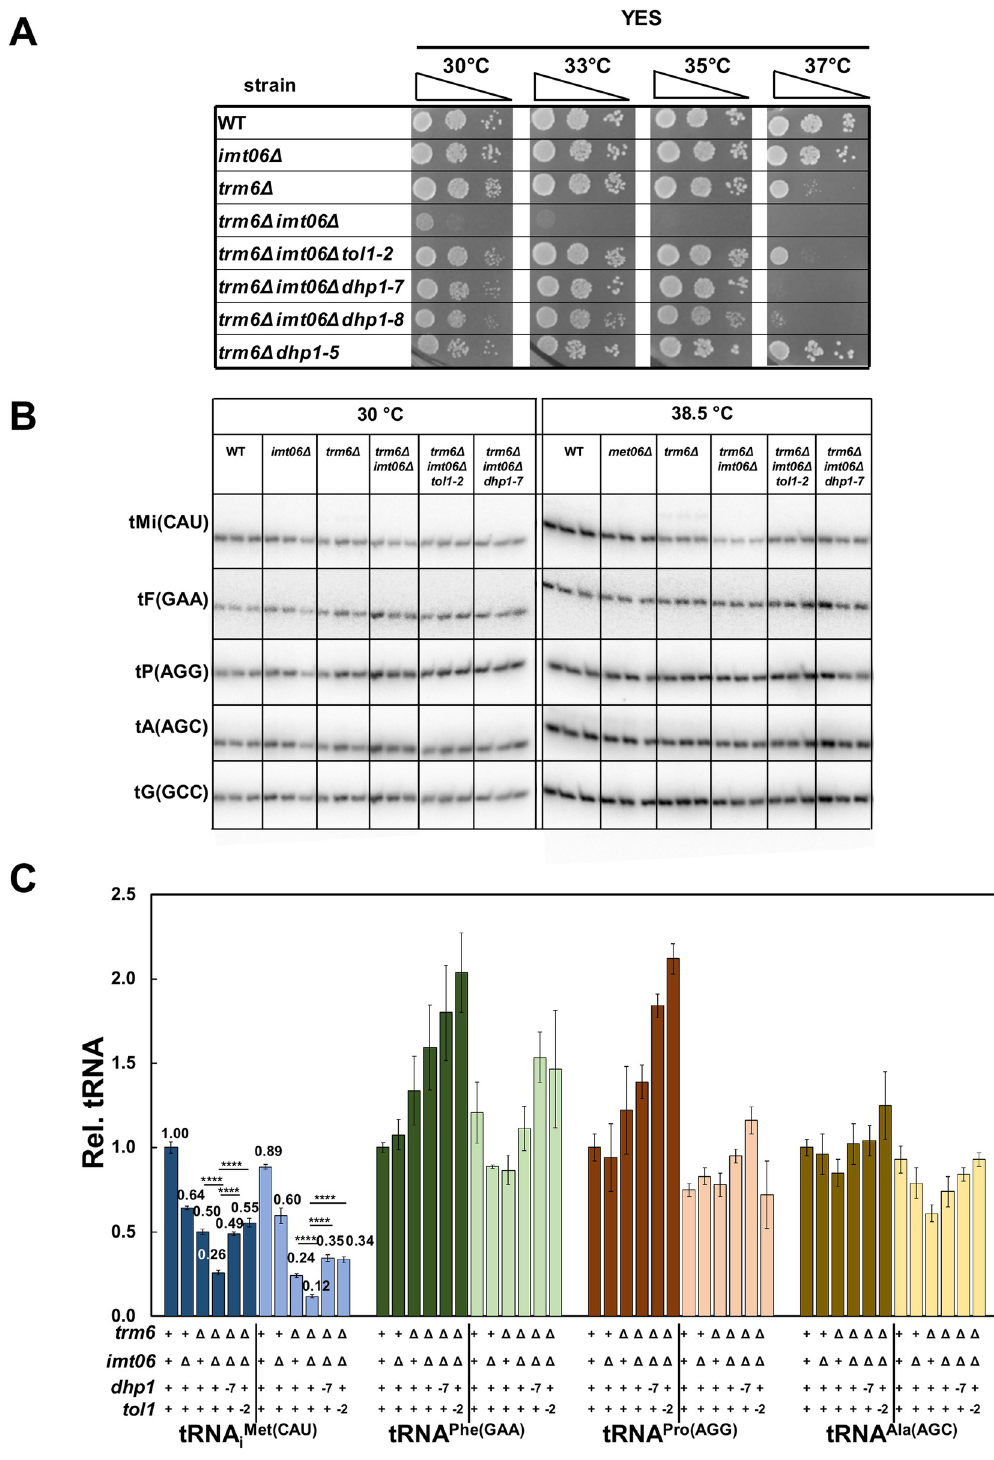
Fig 5. Spontaneous suppressors of S . pombe trm6 Δ imt06 Δ mutants with mutations in dhp1 and tol1 restore growth and increase tRNA iMet(CAU) levels. (A) Spontaneous suppressors of S . pombe trm6 Δ imt06 Δ mutants with mutations in dhp1 and tol1 suppress the growth defect. Strains were grown overnight in YES media at 30˚C and analyzed for growth as in Fig 1A on indicated plates and temperatures. (B) Spontaneous suppressors of S . pombe trm6 Δ imt06 Δ mutants with mutations in dhp1 and tol1 restore tRNA iMet(CAU) levels at low and high temperatures. Strains were grown in YES media at 30˚C